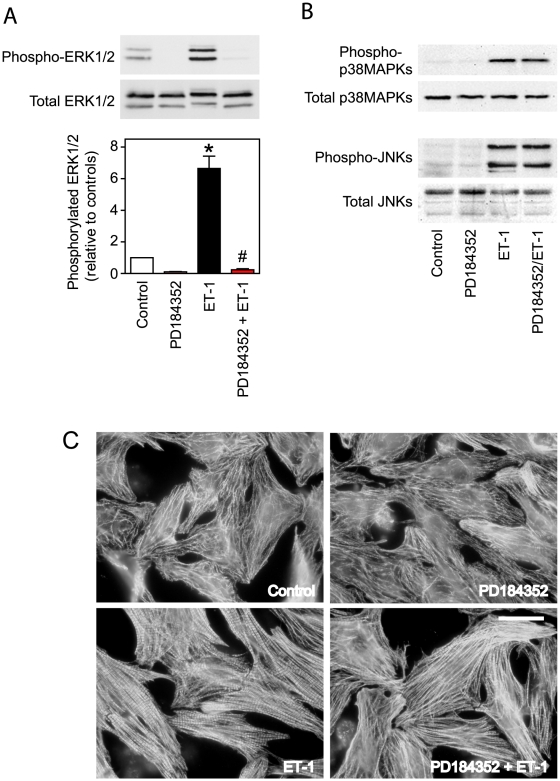
Inhibition of ERK1/2 activation by PD184352.Cardiomyocytes were unstimulated (Control) or exposed to 100 nM ET-1, 2 µM PD184352 or ET-1 in the presence of PD184352. Incubation times with ET-1 were 5 min (for activation of ERK1/2 or p38-MAPK), 15 min (for activation of JNKs) or 1 h (for effects on effects on morphology). A, Phosphorylated (upper panel) or total (center panel) ERK1/2 were assessed by Western blotting. Densitometric analysis is shown in the lower panel as means ± SEM (n = 5 independent experiments). * p<0.001 relative to control, # p<0.001 relative to ET-1 alone (one-way ANOVA with Newman-Keuls post-test). B, Phosphorylated or total p38-MAPKs (upper blots) or JNKs (lower blots) were assessed by Western blotting. The experiment was repeated with similar results. C, Cardiomyocytes were immunostained with antibodies to troponin T. The experiment was repeated with similar results. Bar = 10 µm.